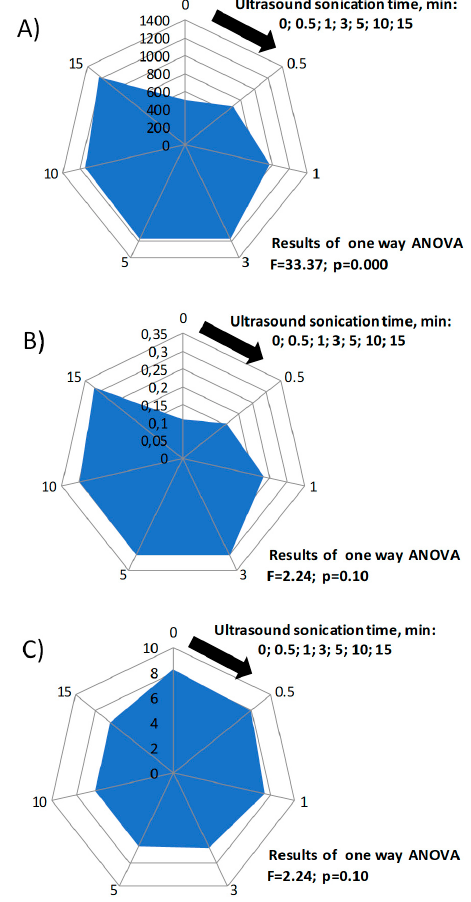
Figure 3. Impact of sonication time on ( A ) BOD 5 , ( B ) BOD 5 /COD, ( C ) pH (graphs with results of statistical analyses—one-way ANOVA).